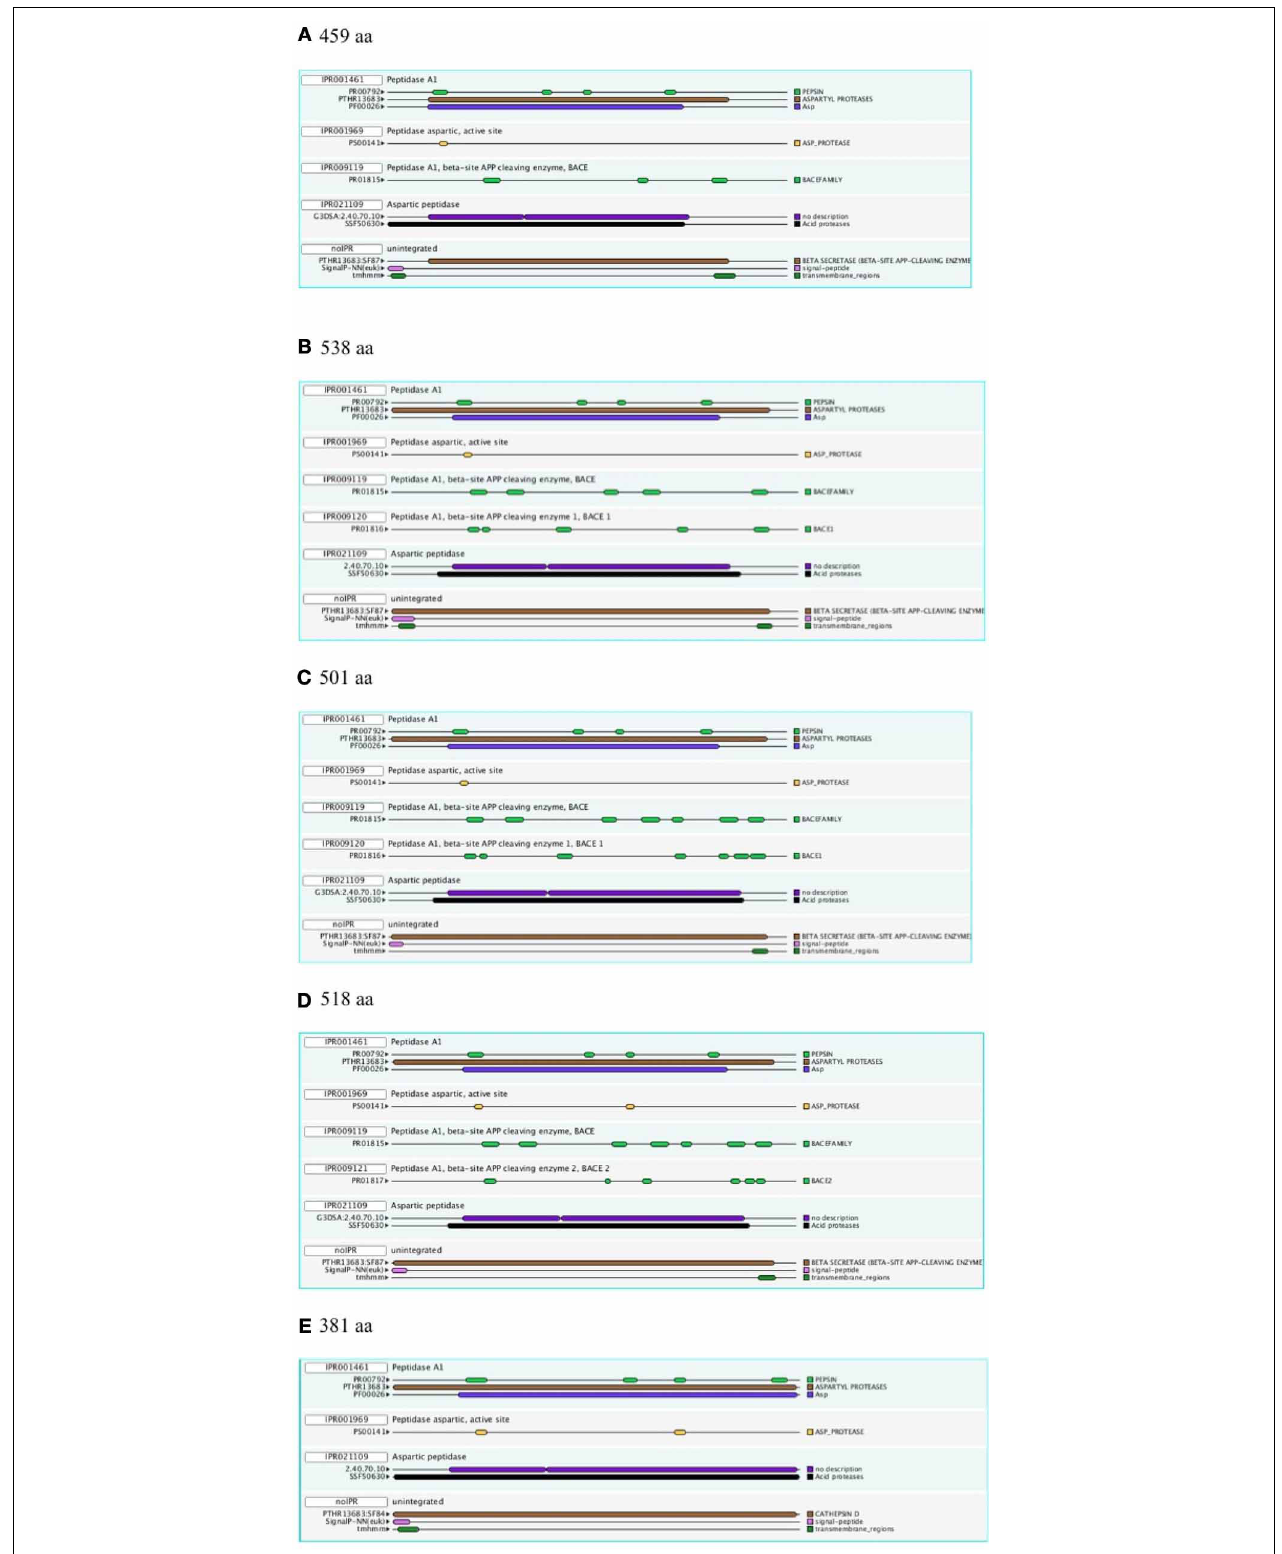
FIGURE 1 | InterProScan Sequence Features. Representative examples are shown for two Ur-BACEs (A) Monosiga ovata A (Mono_ovat_A), (B) Strongylocentrotus purpuratus (Stron_purp), (C) human BACE1